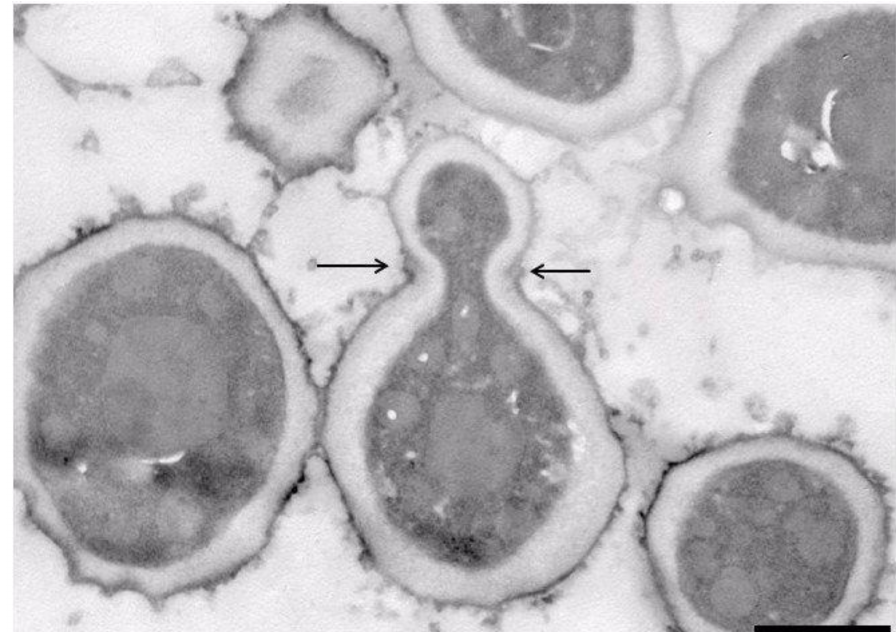
Figure 4. Novakomyces olei NCAIM Y.02187 T . TEM micrograph of a section of a budding cell (5% malt extract, 3 days, 25 ◦ C). Bud scar is indicated by arrows. Bar, 1000 nm. The image was taken by Bence R á cz. Table 3. Some salient characteristics of Taphrinomycotina genera reproducing asexually by budding. Sexual Starch Carotenoid Nitrate Genus Urease DBB CoQ Fermentation Reproduction in Formation Pigments Assimilation Pure